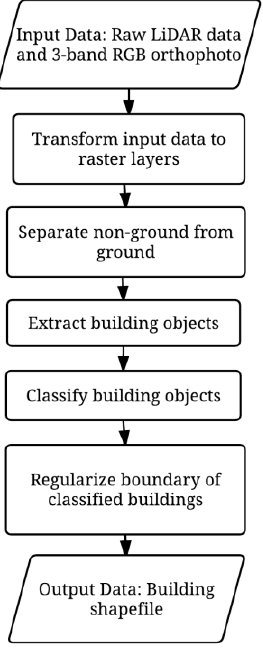
Figure 1. Building extraction workflow.